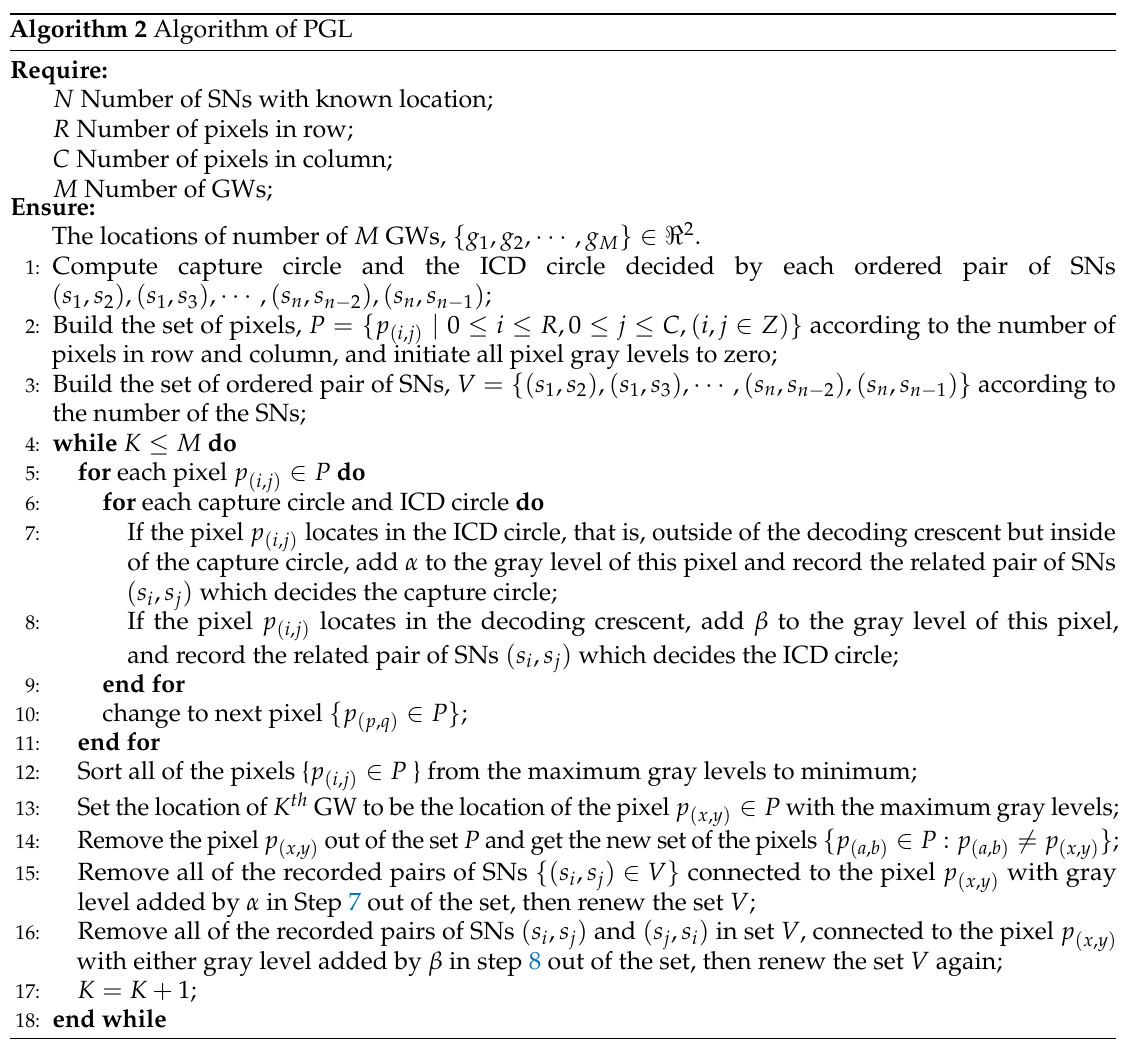
Algorithm 2 Algorithm of